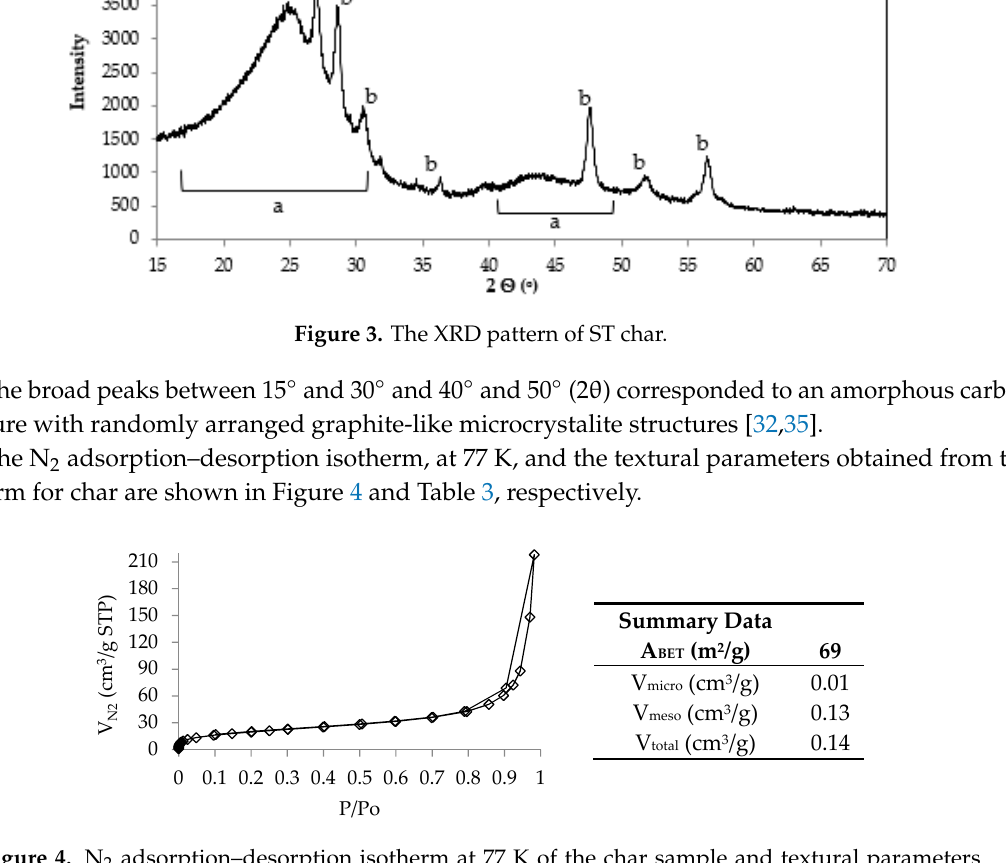
Table 2. Mineral content (mg/kg db) of ST char.